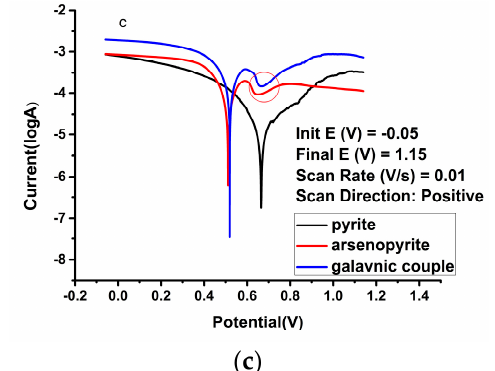
Figure 4. Tafel curves of the three investigated electrodes in sulfuric acid ( a ), ferric ion ( b ), and HQ0211 strain solutions ( c ).